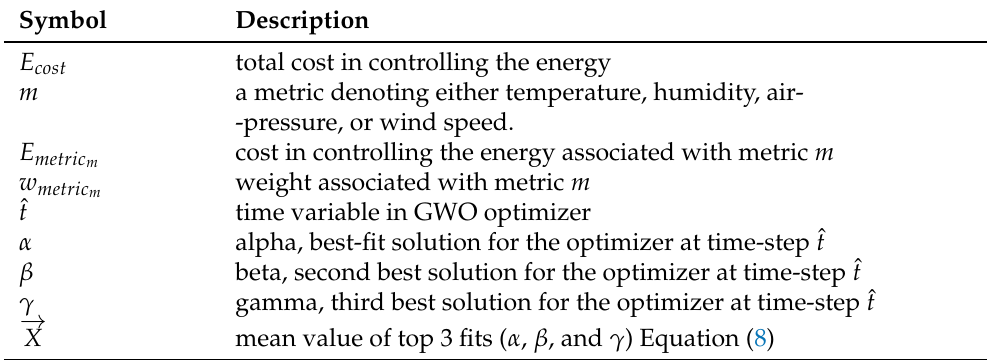
Table 3. Data and variables used in optimization.